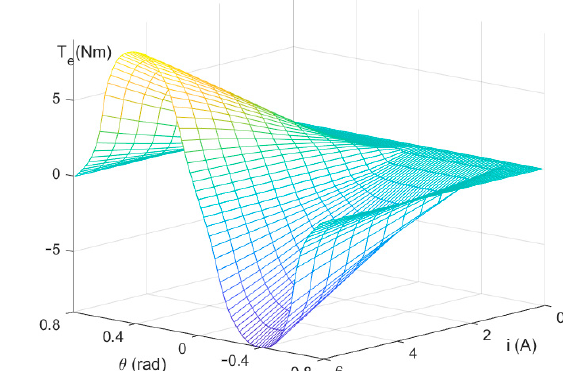
Figure 1. Calculated and measured characteristics of electromagnetic torque T e .